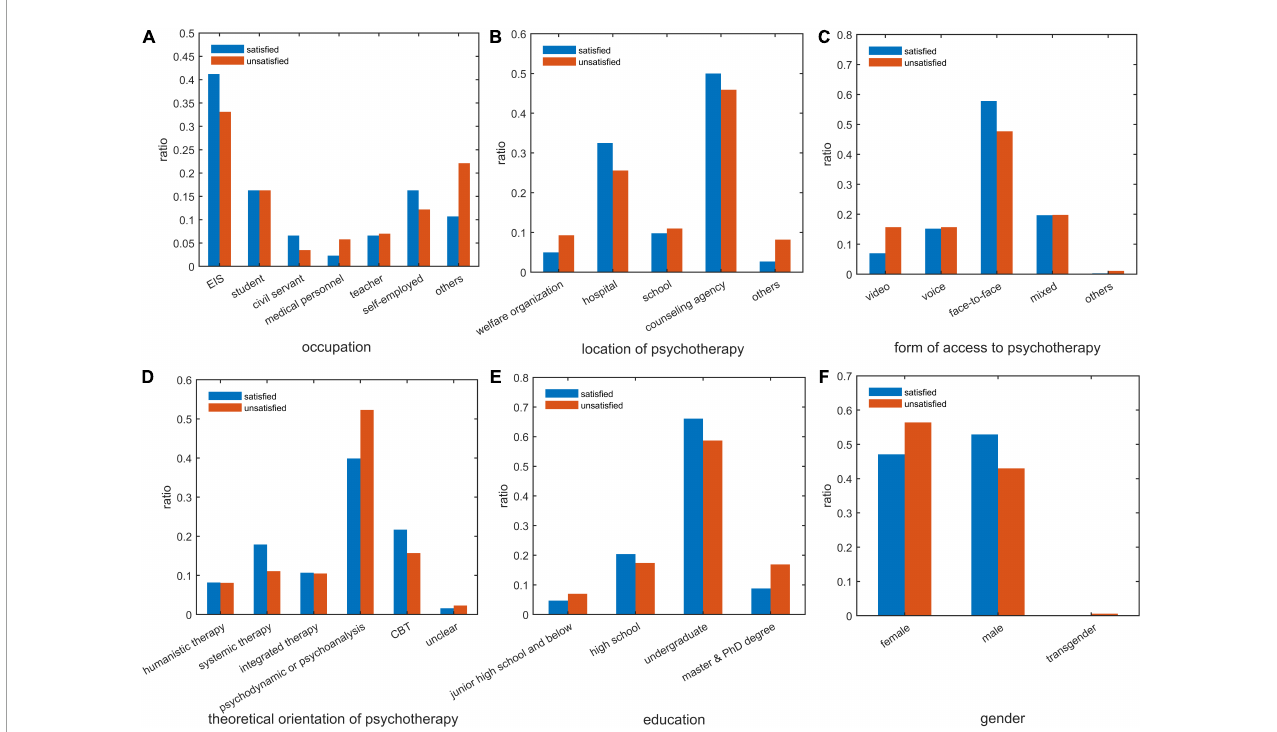
FIGURE2 Comparison of clients’ satisfaction with psychotherapy based on graph metrics. (A) client’s occupation; (B) location of psychotherapy; (C) way of psychotherapy; (D) theoretical orientation of psychotherapy; (E) client’s education; (F) client’s gender. satisfied: participant satisfied with psychotherapy; unsatisfied: participant unsatisfied with psychotherapy. EIS, enterprise and institution staff; CBT, cognitive behavioral therapy.